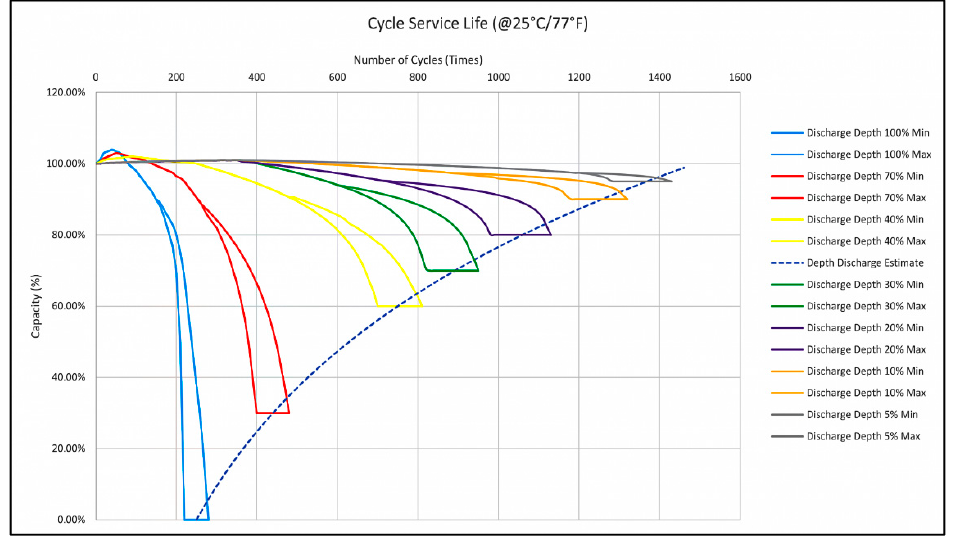
Figure 11. The battery cycle life for LAB with different DoD.